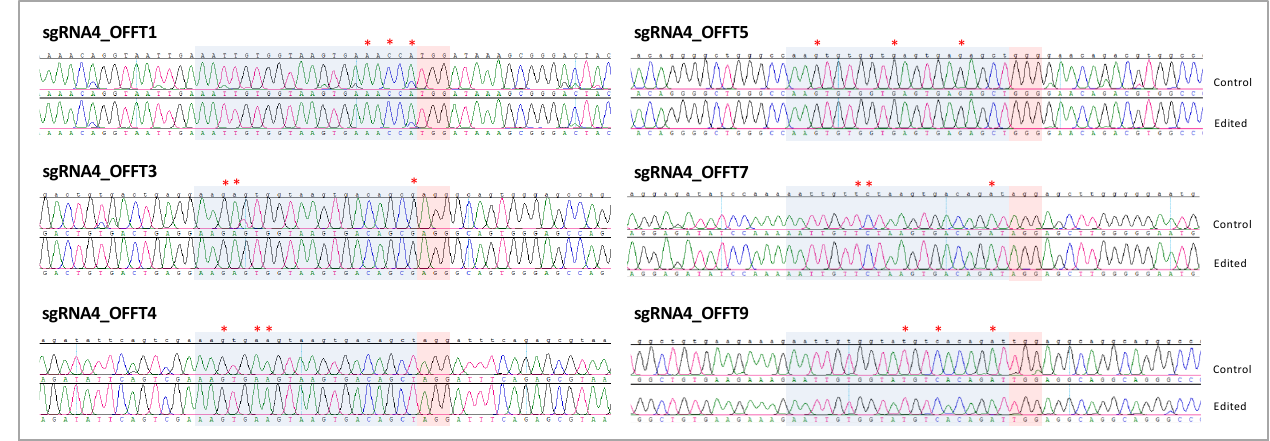
Figure 5. Edited clones exhibit no genomic alterations in potential off-targets. Representative captures of chromatograms showing Sanger sequencing reads of PCR products from the analyzed off-targets for PDE6C sgRNA4. On the top is the GRCh38 reference sequence; below are the results of one control and one homozygous edited clone for each off-target. Sequences homologous to the sgRNA and the adjacent PAM motif are highlighted. Red asterisks depict mismatches in sequence homology with the